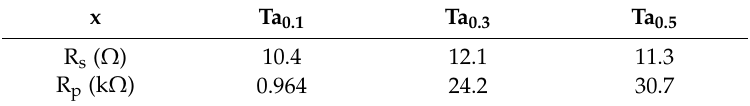
Figure 6. Electrochemical impedance spectroscopy measurements of as-cast CoCrFeNiTa x alloys in 1 M NaCl solution. ( a ) Nyquist plots; ( b ) Bode plots; and ( c ) corresponding equivalent circuit diagrams. Table 5. The resistances of as-cast CoCrFeNiTa x alloys in 1 M NaCl solution.